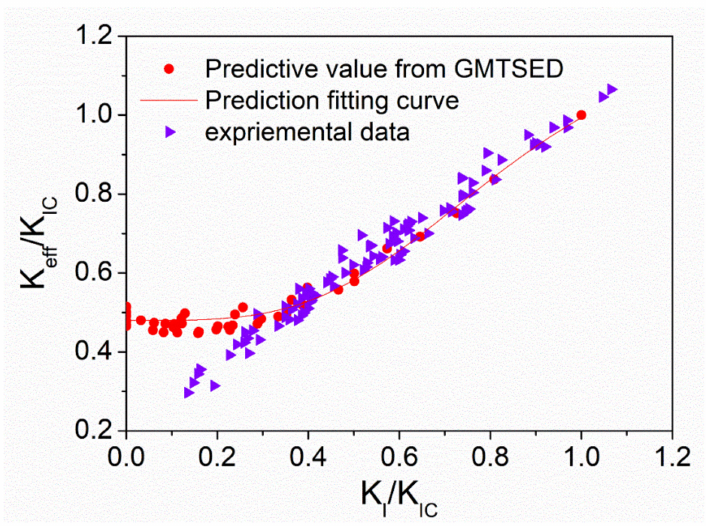
Figure 18. Effective SIF predicted values of the fracture criterion and the testing data for